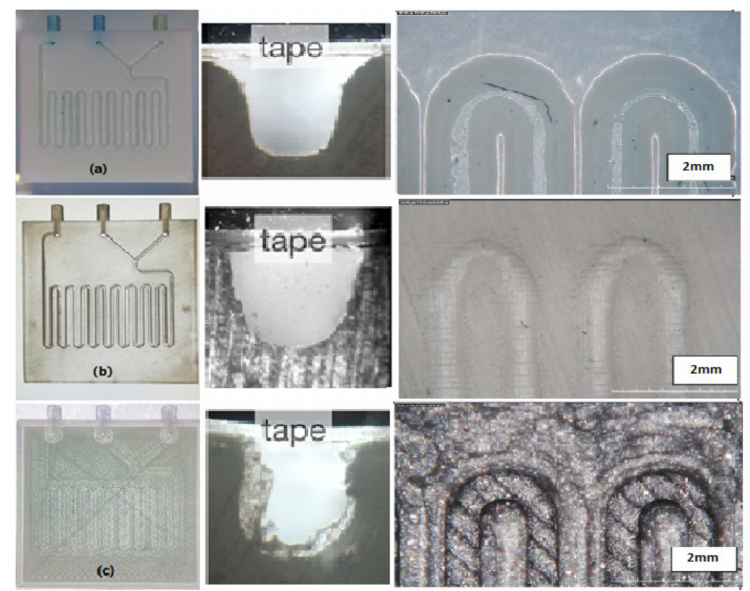
Figure 4. Fabricated micro-mixers by three di ff erent methods of printing. ( a ) micro-mixer with polyjet in cross-section and top view ( b ) micro-mixer with SLA in cross-section and top view ( c ) micro-mixer with FDM in cross-section and top view.